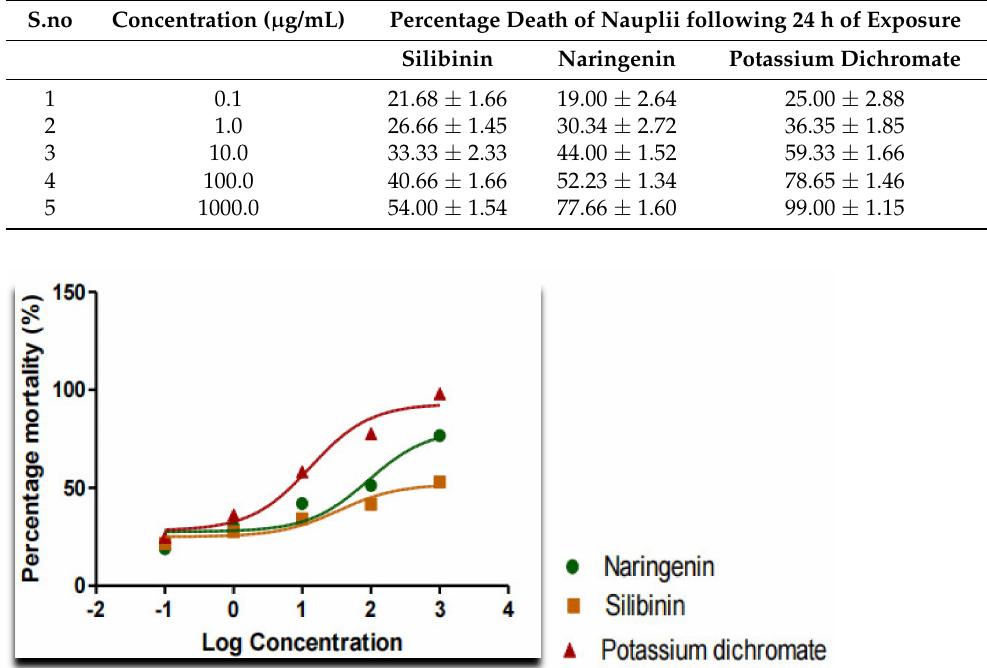
Table 3. Brine shrimp lethality assay for silibinin and naringenin.